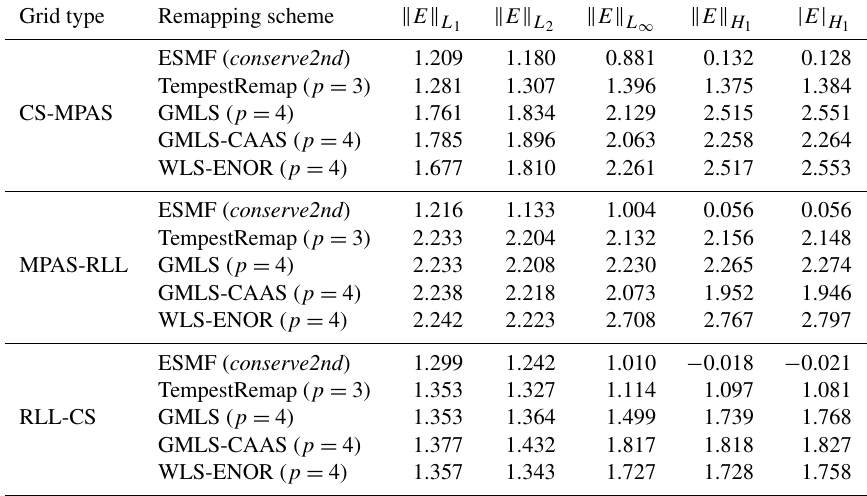
Table 6. Comparing global error measures for the TPW field with different remap schemes on all mesh types of finest (r4) (cid:127) s and (cid:127) t